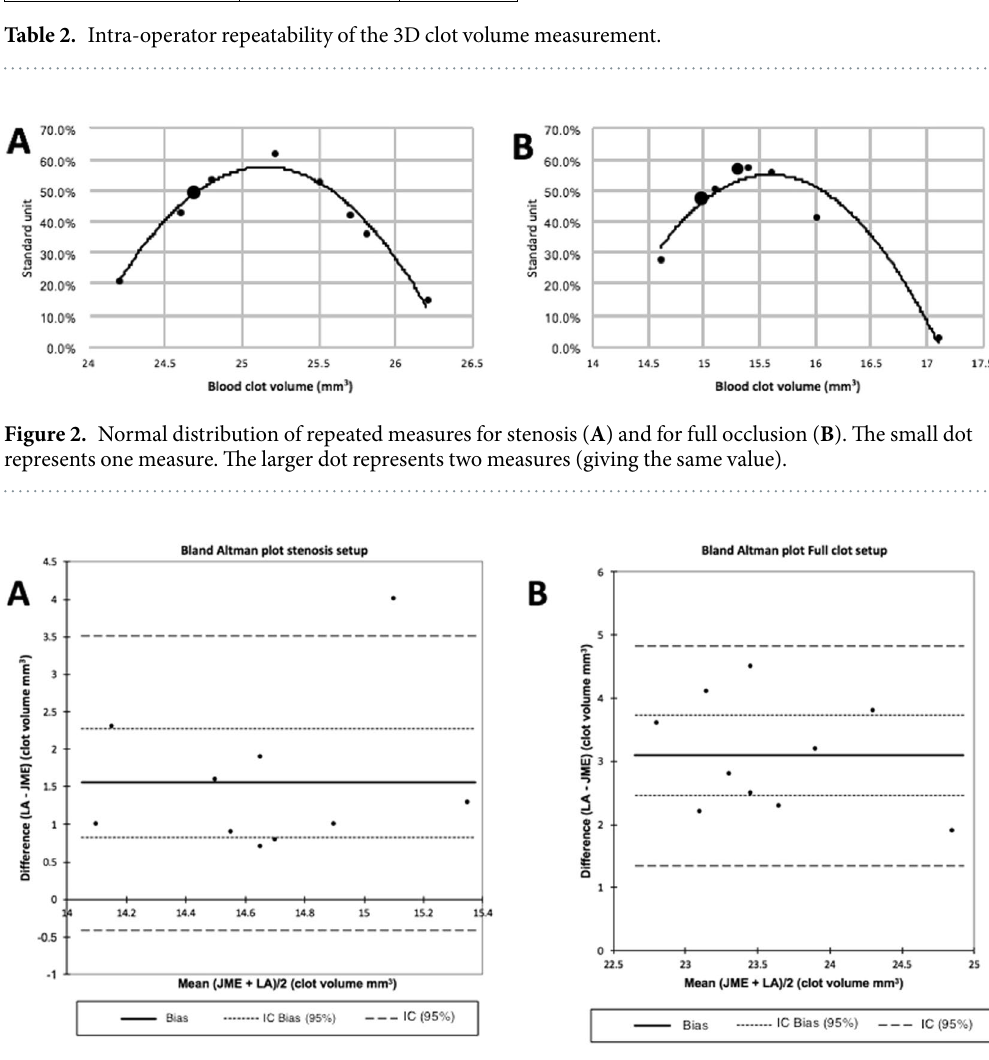
Figure 3. Bland-Altman plot for stenosis ( A ) and the occlusion ( B ) describing the inter-operator